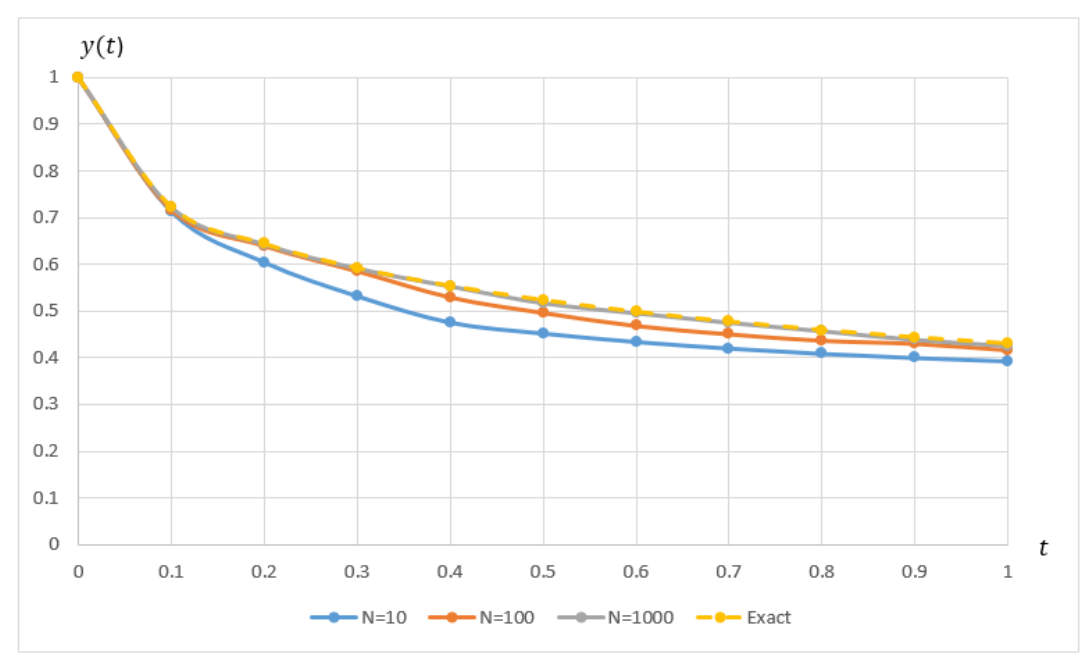
Figure 4. Approximate solution, y ( t ) against each point, t at different N of α = 0.50 when solving Example 1 using FEAM3.